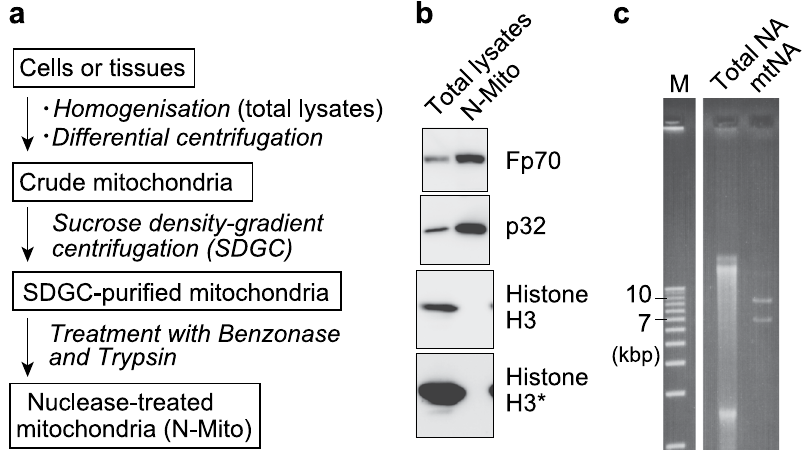
Figure 5. Preparation of mitochondria and highly purified mtDNA. ( a ) Flow of mitochondrial preparation with three grades of mitochondrial fractions and key experimental steps. ( b ) Western blot analysis of total cell lysates (total lysates) and nuclease/protease-treated mitochondrial preparations (N-Mito) from mouse livers using antibodies against Fp70, p32 and histone H3. The panel with histone H3 * is a longer exposure image of the panel above. ( c ) An example of ethidium bromide stained image of liver total NA and liver mtNA purified from N-Mito; they were treated with the restriction enzyme EcoRV, which cuts mouse mtDNA twice to generate 9.5 and 6.8 kb fragments. While corresponding bands were not seen in total NA due to the small proportion of mtDNA compared to nuclear DNA, two bands corresponding to the EcoRV-generated mtDNA fragments were observed in mtNA from N-Mito. A DNA ladder (M) was run on the same gel but not next to the sample lanes. Full-length gel and blots are presented in Supplementary Fig. S6c,d. Note that larger amounts of mtNA were treated with EcoRV and RNase T1 and were electrophoresed for gel purification of mtDNA for LC/MS